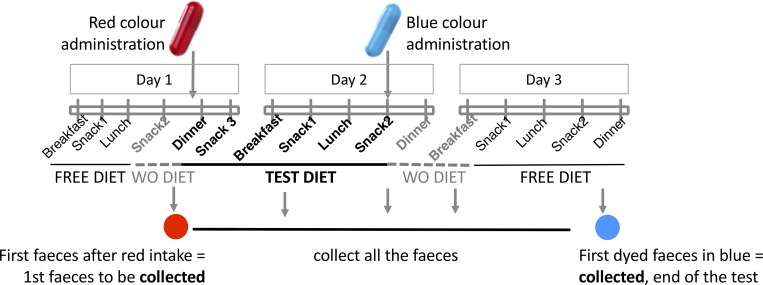
Overview of the study.The study started at day 1 afternoon with a washout diet including a fixed dose of the enzymatic supplement (TOD) (snack 2) and the administration of the red marker. From then on, and during day 2 patients followed the test diet with the fixed dose of the enzymatic supplement (TOD), until the afternoon snack on day 2, that was taken in combination with the blue markers. The dinner of day 2 and the breakfast of day 3 conformed the washout diet after the test menu, also with a fixed dose of the enzymatic supplement (TOD). Faecal samples had to be collected from the moment of the red colour intake until the first blue-dyed deposition was found. For the faecal analysis, researchers selected the samples comprised from the 1st red deposition to the 1st blue. WO, washout.